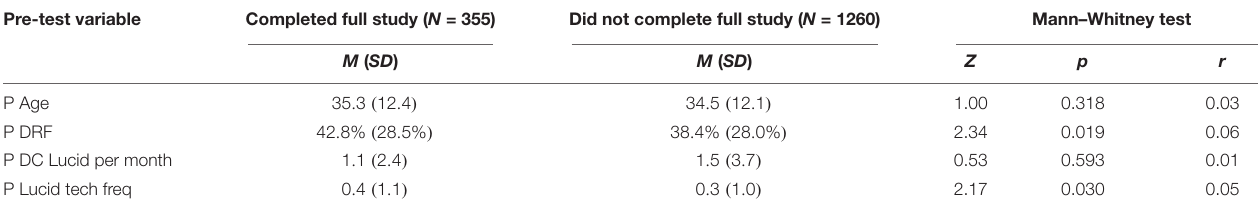
TABLE 1 | Descriptive statistics for pre-test variables with Mann-Whitney tests for differences between participants who did and did not complete the full study. Pre-test variable